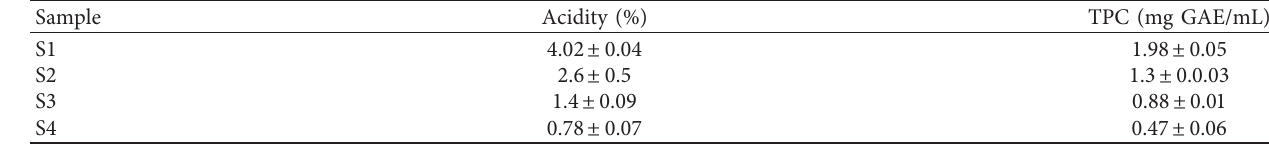
Table 2: Acidity and polyphenolic content in apple vinegar